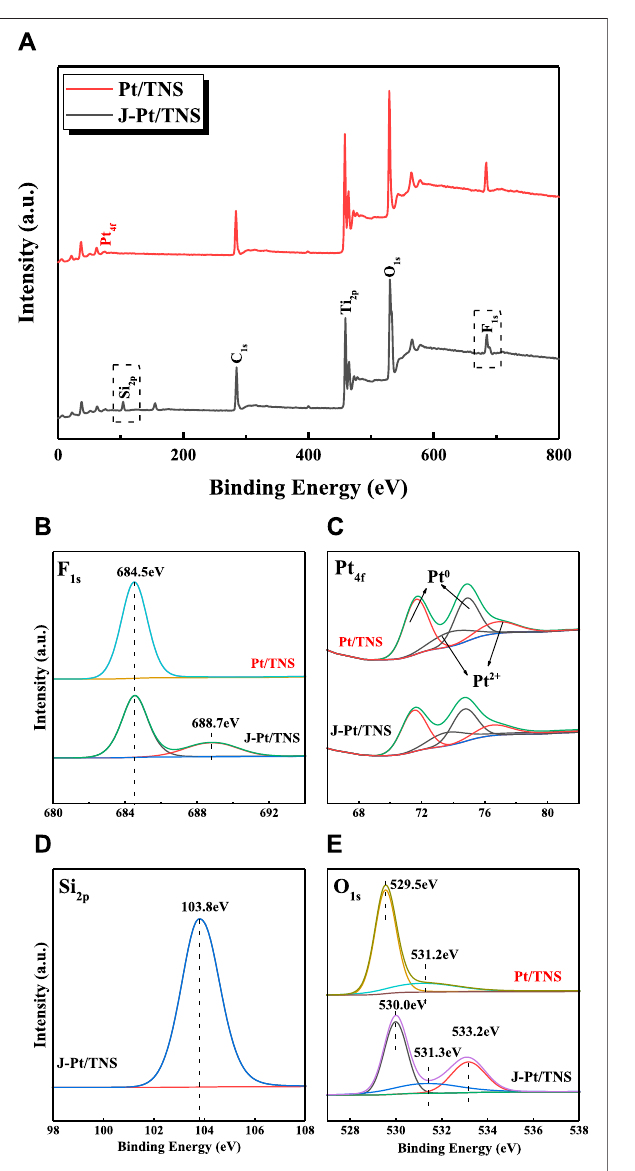
FIGURE 5 | Graphic diagram of the (A) survey and high-resolution XPS spectra of (B) F 1s, (C) Pt 4f, (D) Si 2p for J-Pt/TNS, and (E) O 1s spectra of Pt/TNS and J – Pt/TNS.